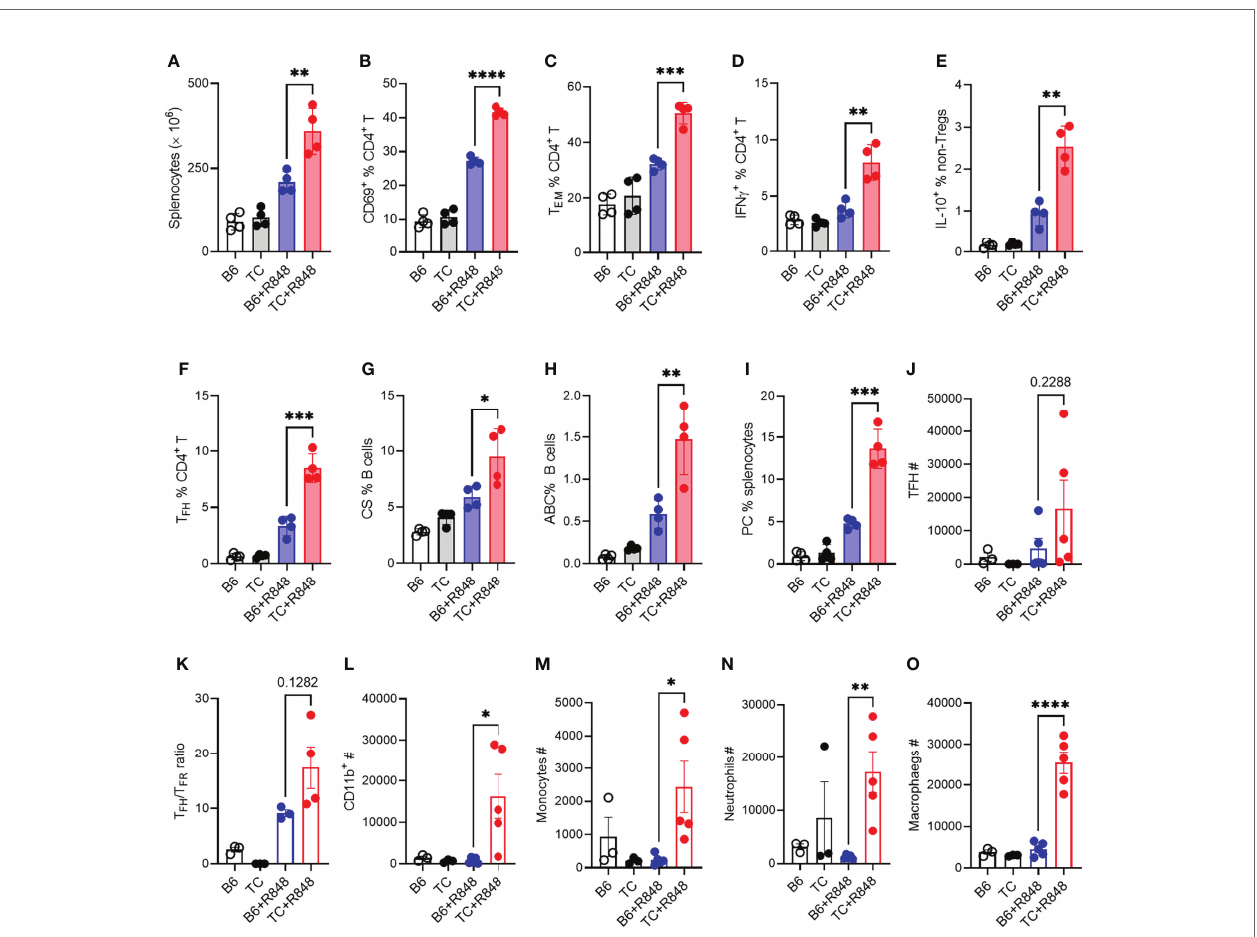
FIGURE 4 | TLR7 activation enhanced lymphocyte activation in TC mice. B6 and TC mice were treated with R848 for 1 week and their splenic CD4 + T cell and B cell phenotypes were compared to untreated age-matched control mice. (A) Splenocyte numbers. Frequency of CD4 + T cells expressing CD69 (B) , presenting the CD62L - CD44 + Tem phenotype (C) , expressing IFN g (D) or IL-10 excluding Foxp3 + cells, (E) . Frequency of PD1 hi CXCR5 + BCL-6 + Tfh cells (F) , CD19 + IgM - IgD - class- switched (CS) B cells (G) , TBET + CD11c + B cells ABCs, (H) CD138 + B220 lo plasma cells PC, (I) . In another experiment, B6 and TC mice were treated with R848 for 2 week and sacri fi ced at the end of week 3. T cells and myeloid cells phenotypes in the heart were compared to untreated control mice. (J) Number of Tfh cells; (K) Ratio of Tfh to Tfr cells; Numbers of CD11b + cells (L) , monocytes (M) , neutrophils (N) , and macrophages (O) . n = 3 - 5 per group. t tests, *: P < 0.05, **: P < 0.01, ***: P < 0.001. ****: P < 0.0001.